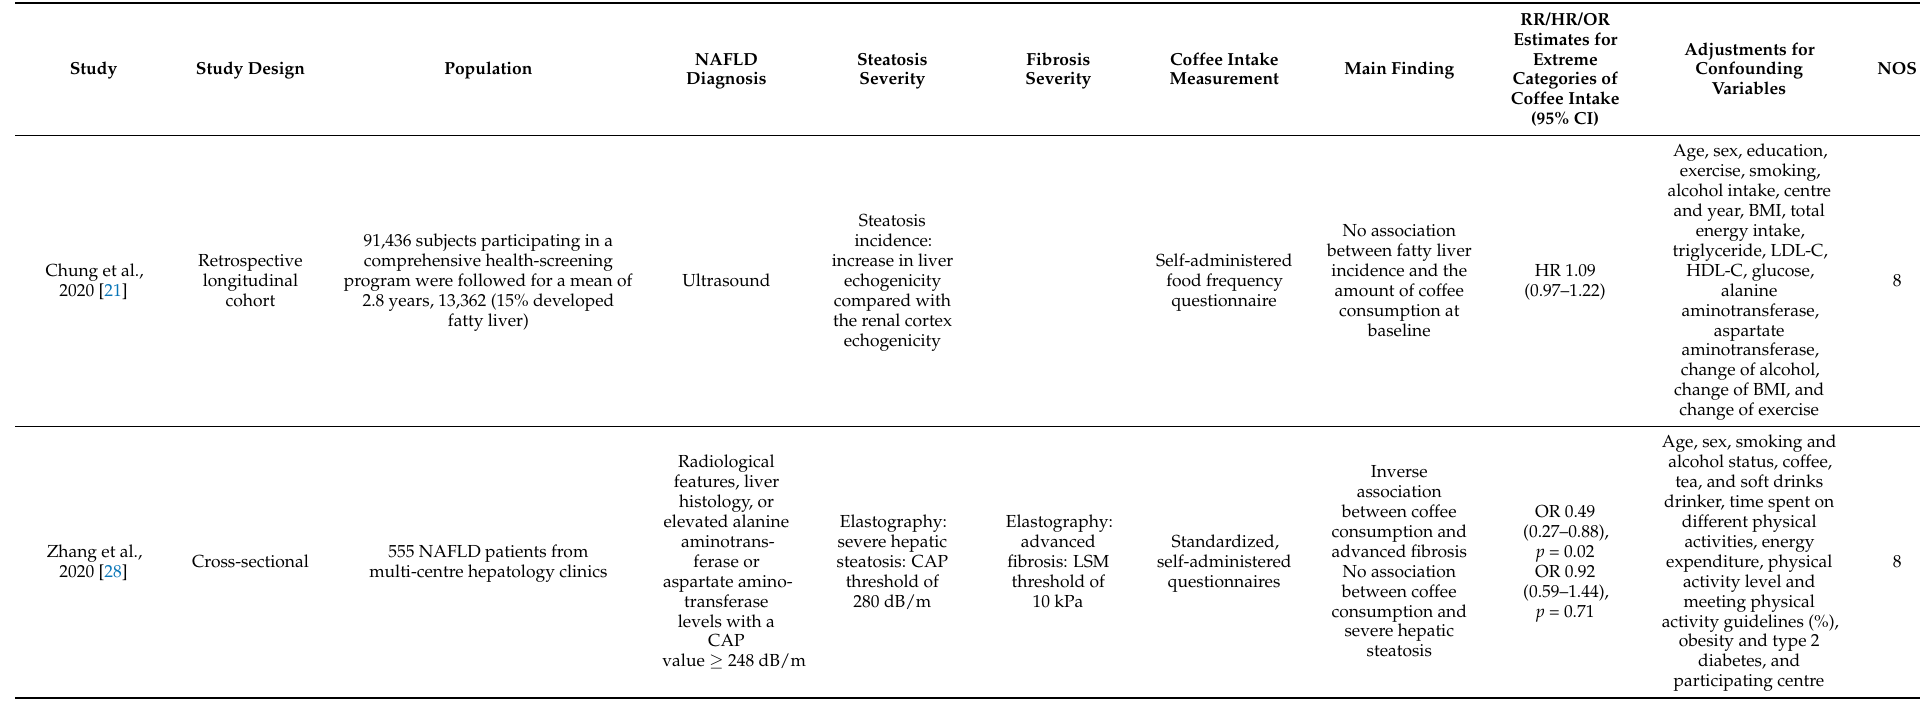
Table 1. Summary of studies investigating the impact of coffee consumption on NAFLD incidence, prevalence, and liver